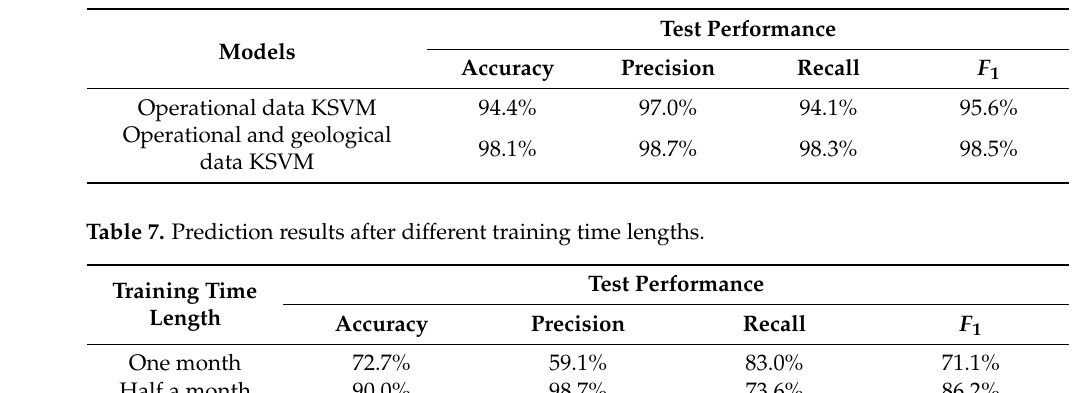
Table 6. Average performance results of the proposed model with and without geological inputs.